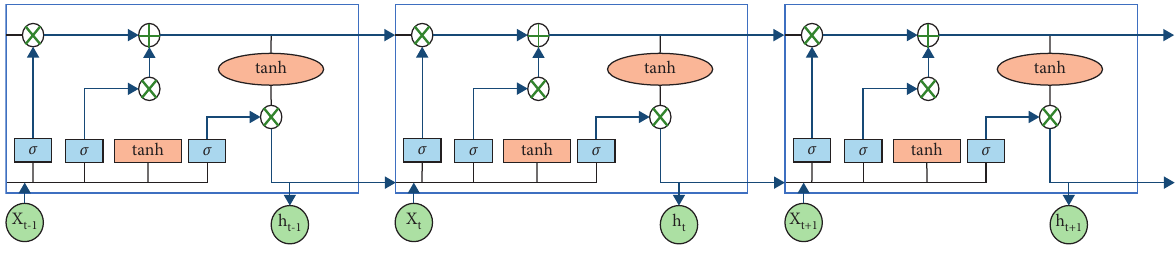
Figure 1: The internal structure of LSTM.